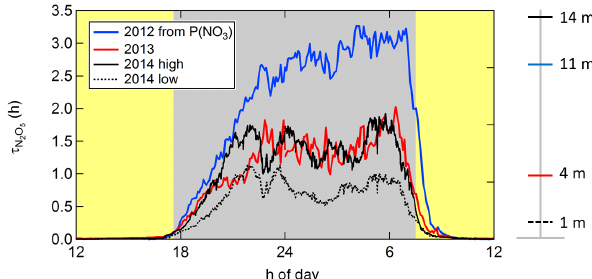
Figure 9. The effect of inlet height on calculated lifetimes. Red and blue lines are the same as in Fig. 7. Black lines are calculated from 2014 measurements with the solid line from an inlet at 14m and the dashed line from an inlet at 1m. These inlet heights span the inlets in 2012 at 11m and 2013 at